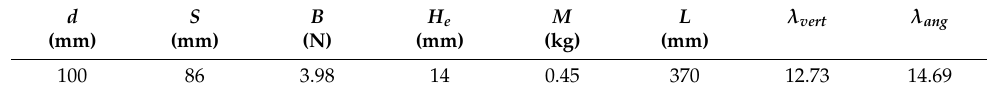
Table 2. Summary on the buoy model